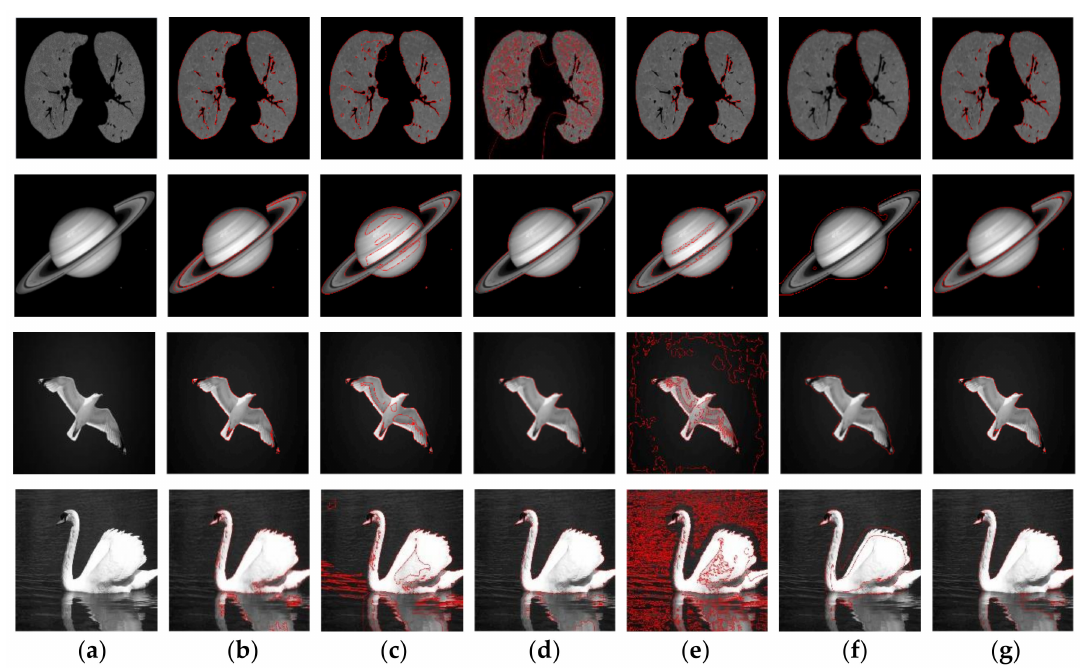
Figure 6. The segmentation results obtained for real images using the six models. ( a ) Original image, ( b ) C–V model, ( c ) LBF model, ( d ) SBGFRLS model, ( e ) LIF model, ( f ) LSACM model, and ( g ) SPFLIF-IS